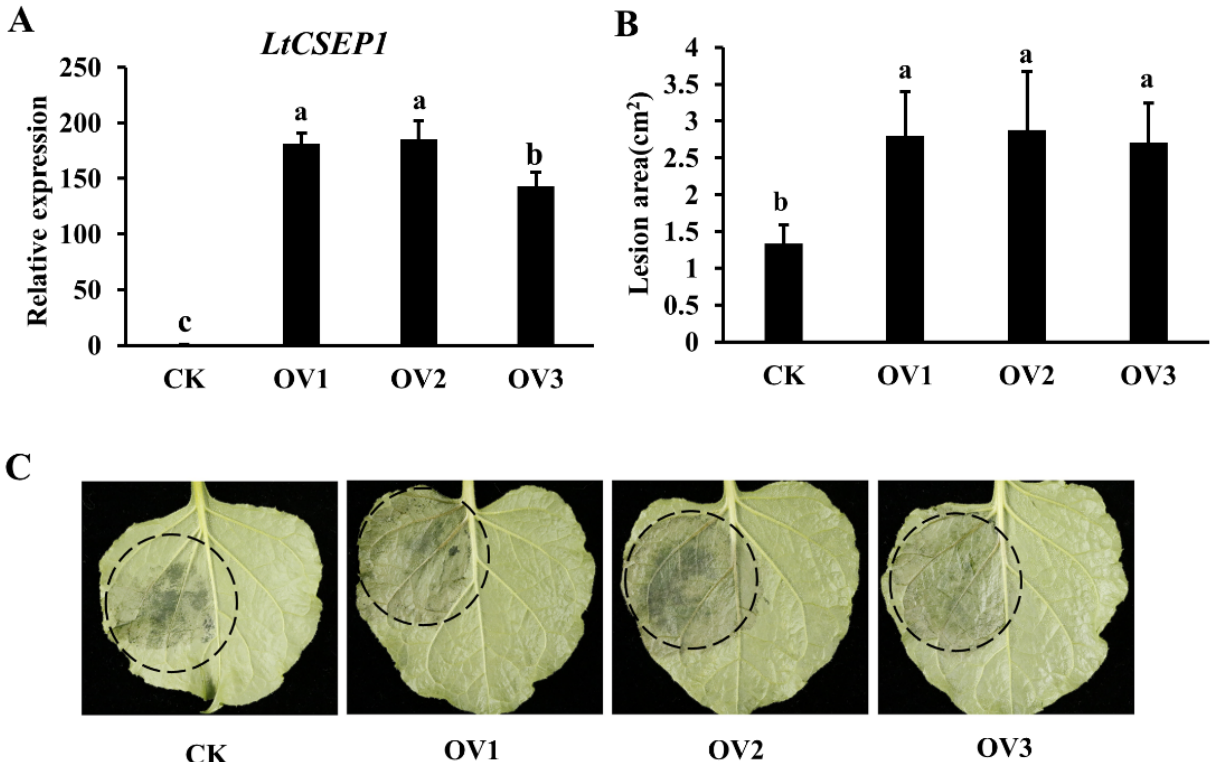
Figure 5. Overexpression of LtCSEP1 in Nicotiana benthamiana enhanced the susceptibility of plants to Lasiodiplodia theobromae . ( A ) Transcript levels of LtCSEP1 in transgenic overexpression lines (OV1, OV2, and OV3) as revealed by qRT-PCR. The expression of NtEF1 α was used as the endogenous control. CK, the wild type N. benthamiana plants. ( B ) Lesion areas on LtCSEP1 transgenic lines infected with L. theobromae CSS-01s at 5 days post-infection (dpi). At least ten leaves from each line were inoculated with L. theobromae CSS-01s. ( C ) Typical leaves with lesions resulting from L. theobromae 5 days post-infection (dpi). Error bars indicate the mean values of three independent biological repetitions with standard errors. Different letters represent significant differences ( p < 0.05).